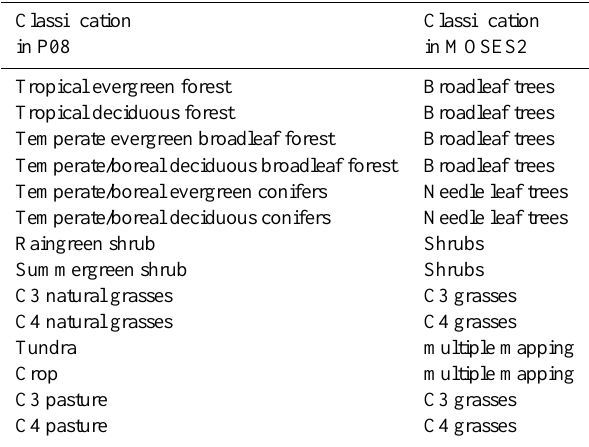
Table 4. Mapping of the P08 land classes into HadGEM2-ES veg- etation types.